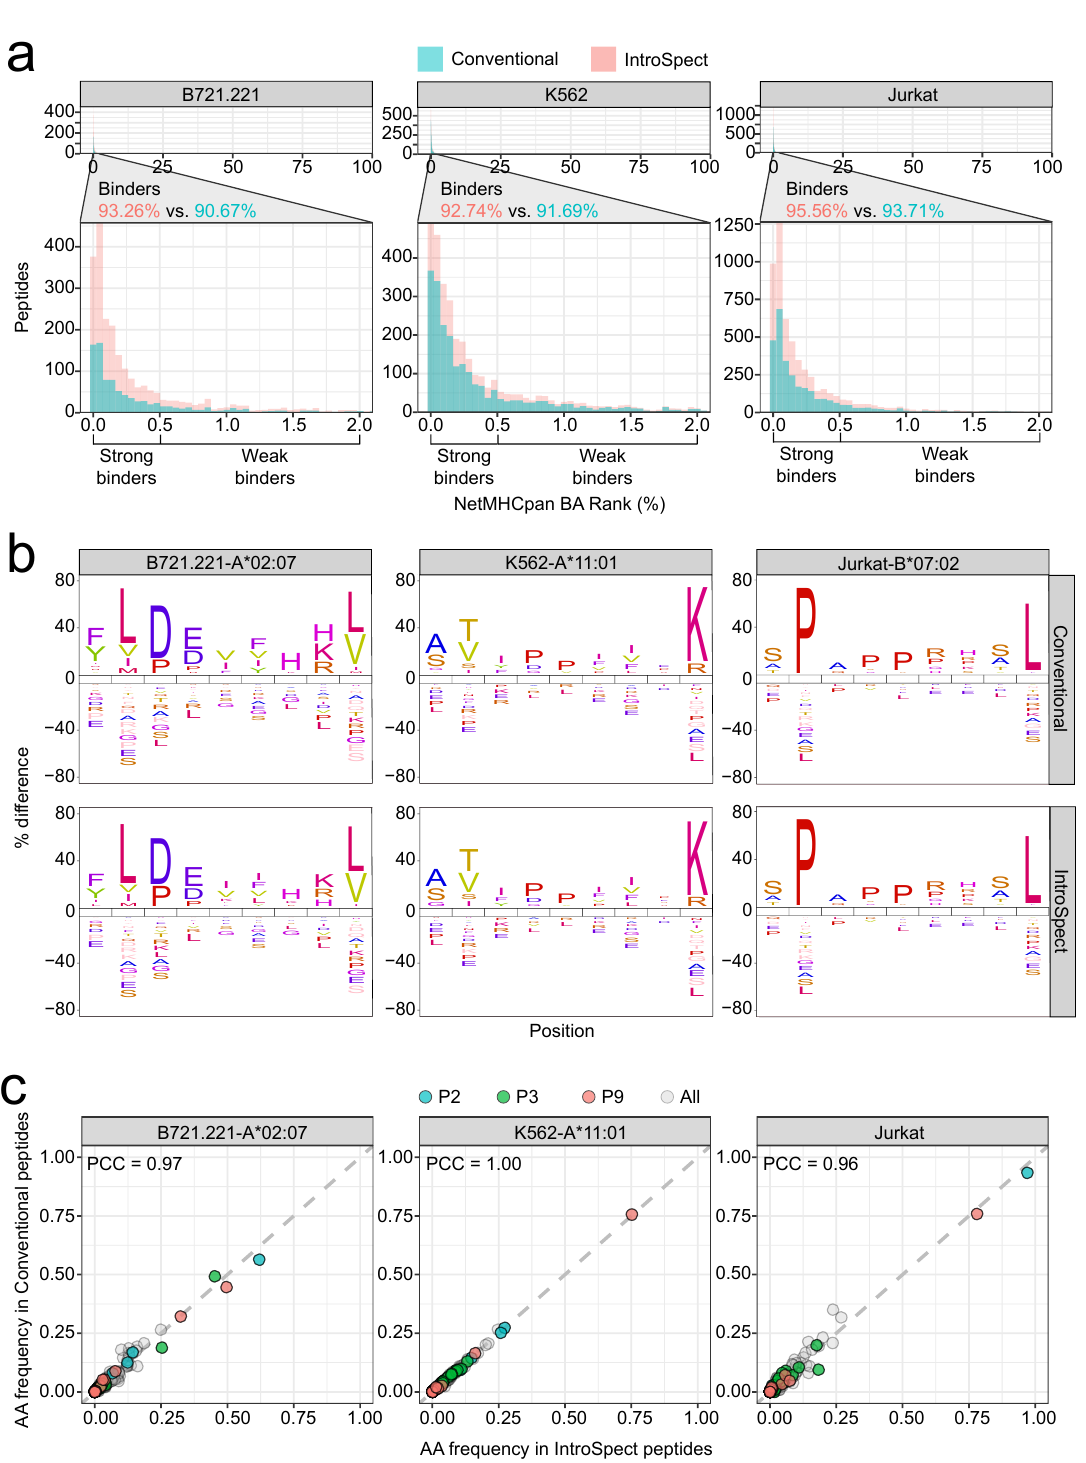
Figure 2. Immunopeptides from IntroSpect and conventional database search are very similar. ( a ) The histogram of predicted BA rank values of peptides identified by conventional and IntroSpect search: the peptides in separate panels are predicted to be strong or weak binders (BA rank < 2%), with their percentages marked on the panel. ( b ) The sequence logos of immunopeptides in three datasets (B721.221-A*02:07, K562-A*11:01 and Jurkat-B*07:02) identified by the conventional and